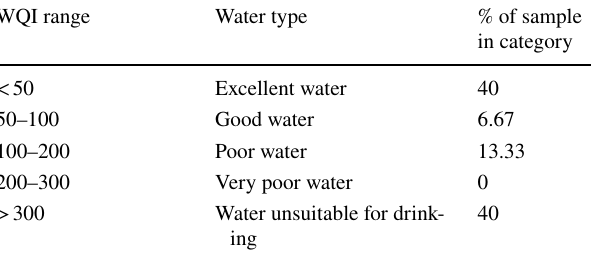
Table 8 Water quality classification based on WQI and % of samples in each class